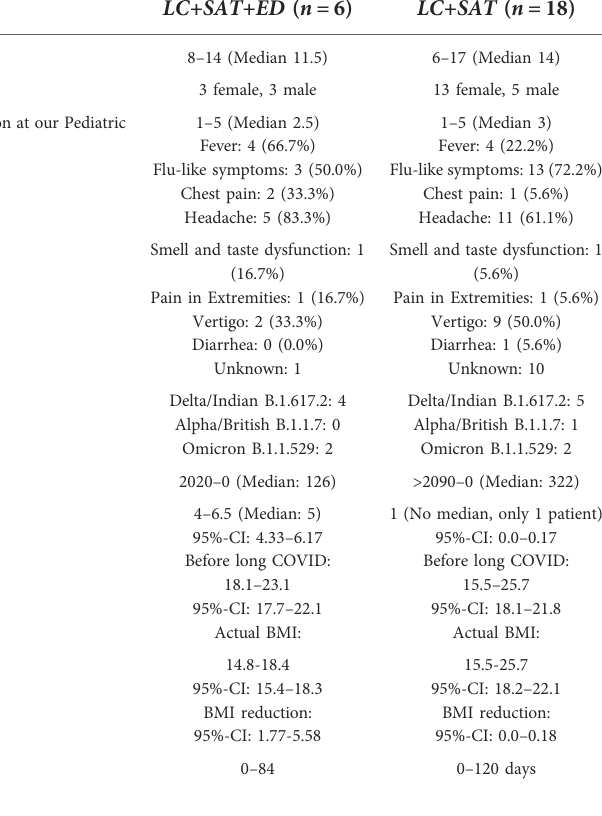
TABLE 3 Patient characteristics and COVID-19 associated